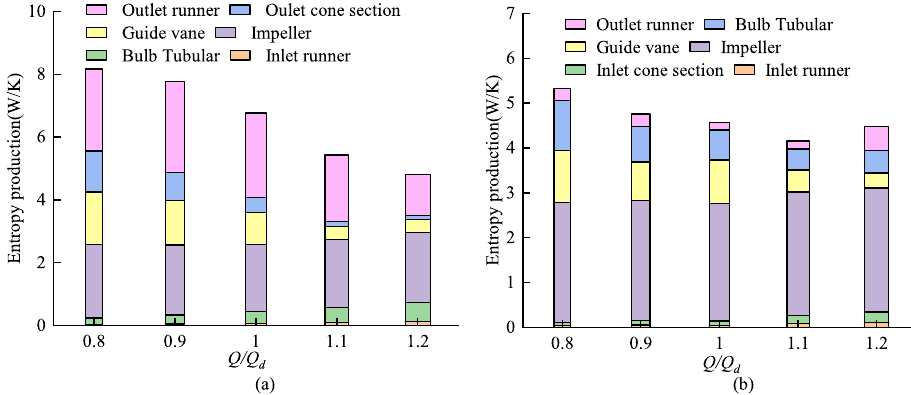
Figure 12. Entropy generation analysis: ( a ) front-mounted scheme; ( b ) rear-mounted scheme.